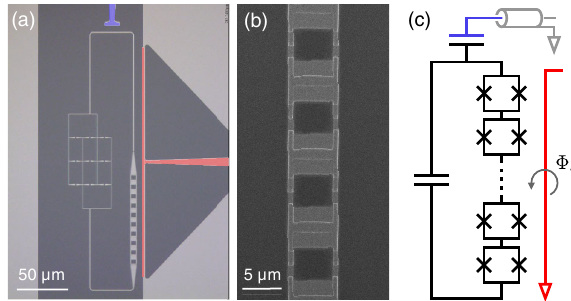
FIG. 5. (a) False colored micrograph of the Kerr parametric oscillator. The coupling capacitor and flux bias line are shown in blue and red, respectively. The capacitor shunting the SQUID array is shaped in an unconventional way in order to accom- modate an array of nanomechanical resonators introduced in later devices [36]. (b) SEM image of the SQUID array. (c) Circuit diagram of the Kerr parametric oscillator, showing the SQUID array and shunting capacitor (black), coupling capacitor (blue) and transmission line (grey), and flux bias line (red).